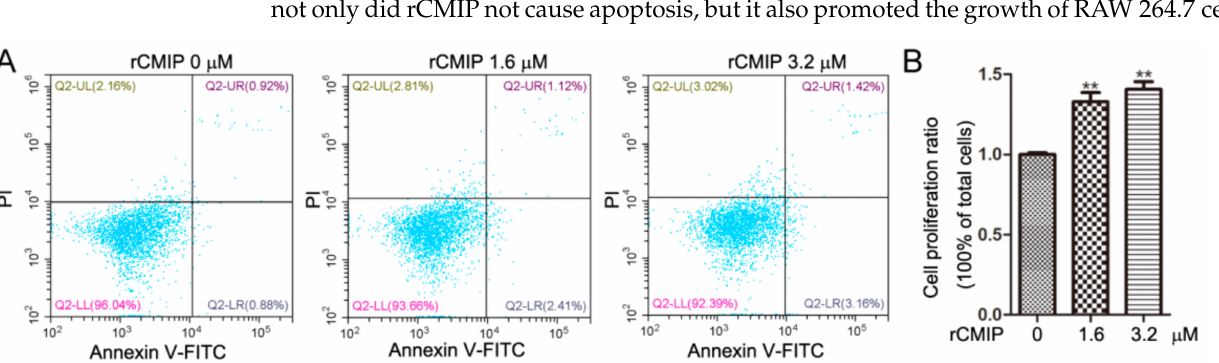
Figure 3. Effect of rCMIP on the growth of RAW 264.7 cells. ( A ) RAW 264.7 cells were treated with 1.6 µ M and 3.2 µ M of rCMIP for 24 h. Cells treated with PBS acted as the control. The apoptotic RAW 264.7 cells gated on Annexin V+/PI- were determined by Annexin V/PI double staining and a flow cytometric assay. ( B ) Cell proliferation of RAW 264.7 cells treated by rCMIP (0 µ M, 1.6 µ M and 3.2 µ M) for 24 h was analyzed by CCK-8 assay. The data shown are the means ± SD ( ** p < 0.01) of three independent